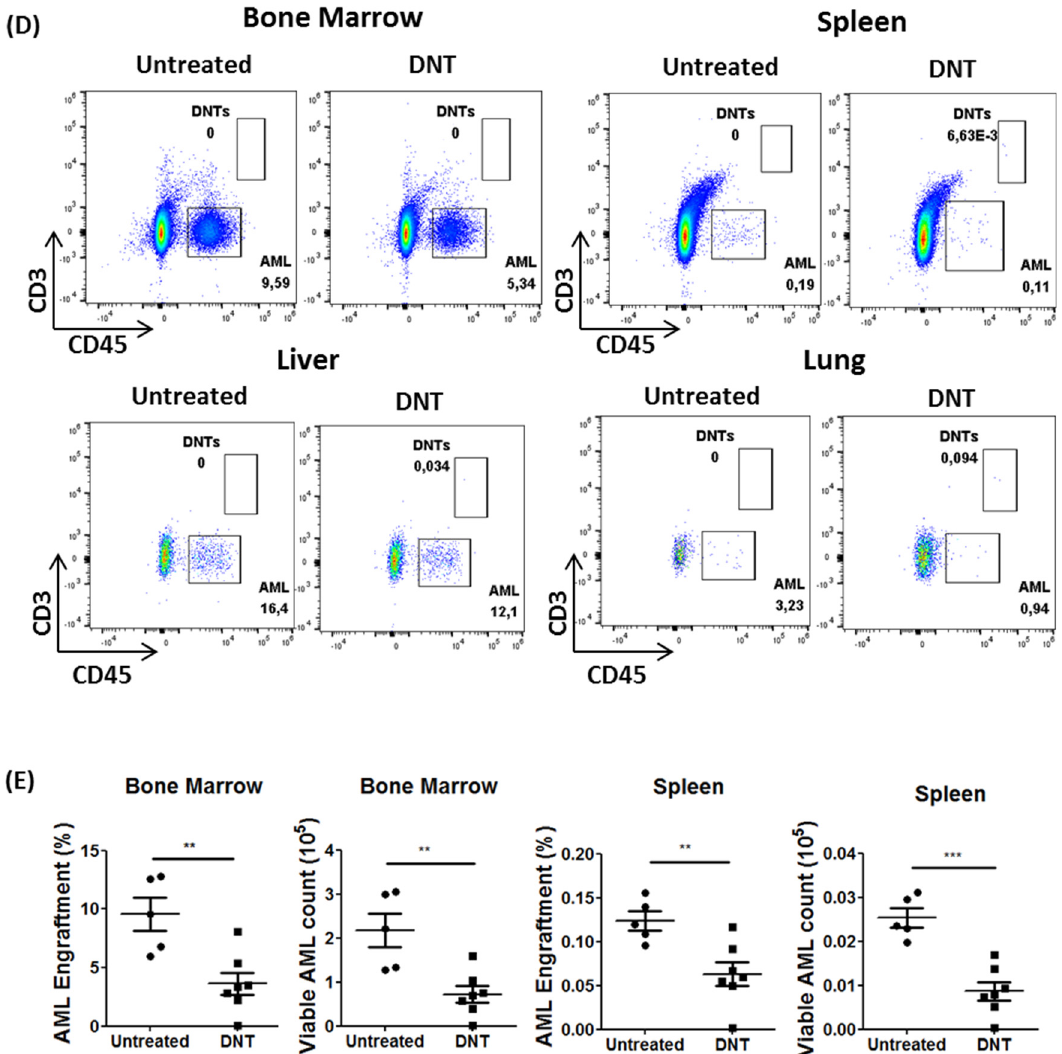
Figure 1. DNT persistence and anti-leukemic activity in leukemia-bearing hosts. ( A ) Schematic diagram of patient-derived xenograft model used. Sublethally irradiated NSG mice were infused with 2–3 × 10 6 primary AML patient sample on day 0. On day 17 and 20, mice were infused with 2 × 10 7 DNTs. Mice were sacrificed, and DNT and AML engraftment were assessed in various tissues on day 37 or day 70. ( B , C ) NSG mice engrafted with a primary AML sample (090543) were treated with PBS or DNT as described in ( A ). ( B ) Number of viable DNTs engrafted in the bone marrow, spleen, blood, liver, and lung were assessed on day 37, which was 17 days post DNT infusion. ( C ) Number of DNTs detected in mice peripheral blood from day 14 to 45 days post DNT infusion. Each symbol represents individual mice, and error bars represent SEM. ( D , E ) NSG mice engrafted with a primary AML sample (130624) were treated with PBS or DNT as described in above. Mice were sacrificed and DNT and AML engraftment were assessed in various tissues on day 70, which was 50 days post-treatment. ( D ) Representative flow plots showing AML engraftment (CD45 low + CD3 − ) and DNT engraftment (CD45 high + CD3 + ) from untreated and DNT treated groups. ( E ) Dot plot shows frequency and number of viable AML cells in untreated ( n = 5) and DNT-treated ( n = 7) mice bone marrow and spleen. Each symbol represents individual mice, the horizontal bars represent the mean, and the error bars represent SEM. The result is representative of two similar experiments with different AML primary blasts. * p < 0.05, ** p < 0.01, *** p < 0.001 .